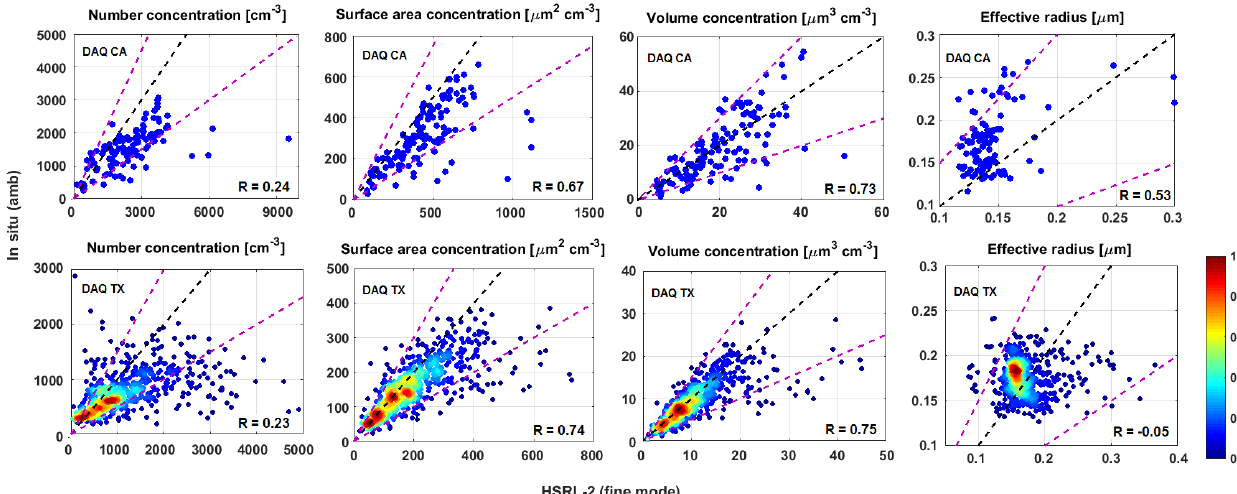
Figure 6. Comparison of number, surface-area and volume concentrations, and effective radius (fine mode only) for all coincident points between HSRL-2 ( x axis) and in situ (corrected for ambient RH; y axis) obtained during DAQ CA and TX. The black dashed lines represent 1:1 and the magenta dashed lines represent ± 50%. R values correspond to correlation coefficients. There are 126 points in the DAQ CA plots and 630 data points in the DAQ TX plots. For the latter, due to the large number of overlapping points, the scatter plot is color-coded by the density of points. The colorbar is normalized to 1.